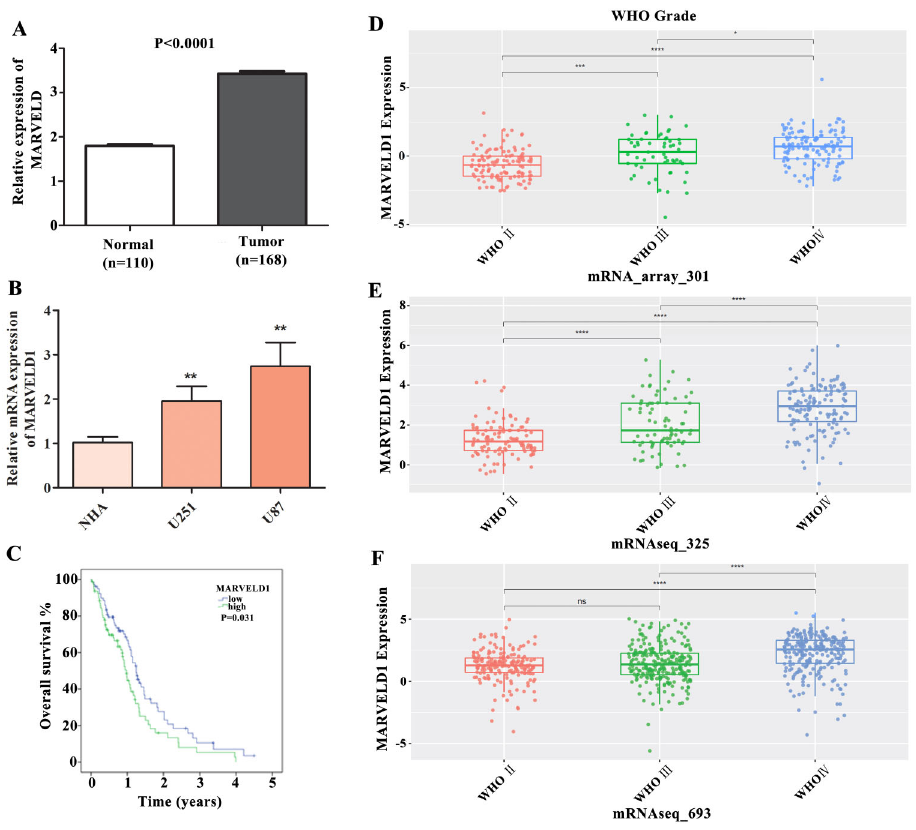
Figure 1. MARVELD1 was expressed at high levels in glioma and correlated with prognosis and WHO grade. A , The differential expression of MARVELD1 in glioma patients (n=168) and healthy controls (n=110) were analyzed based on the TCGA and GTEx databases. B , MARVELD1 expression in glioma cell lines (U87 and U251) and control (NHA) was measured using qRT-PCR. C , The relationship between the MARVELD1 level (high or low) and the survival time of glioma patients was assessed using Kaplan Meier analysis. D – F , MARVELD1 expression in WHO stage II – IV glioblastoma was analyzed based on CGGA databases (mRNA_array_301, mRNAseq_325, mRNAseq_693). Data are reported as means ± SD. **P o 0.01 (Student ’ s t -test or one-way ANOVA with Dunnett ’ s